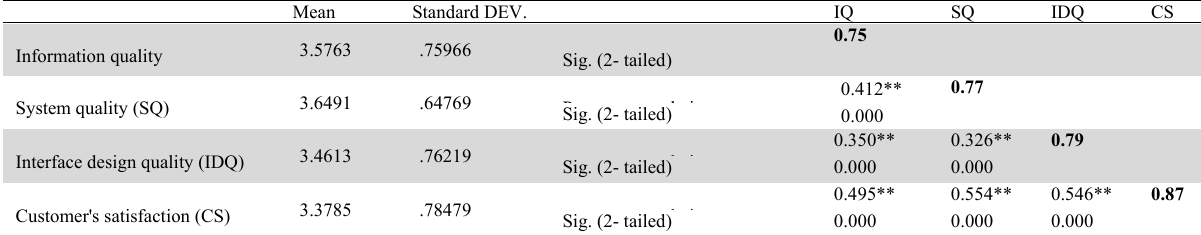
Discriminant Validity